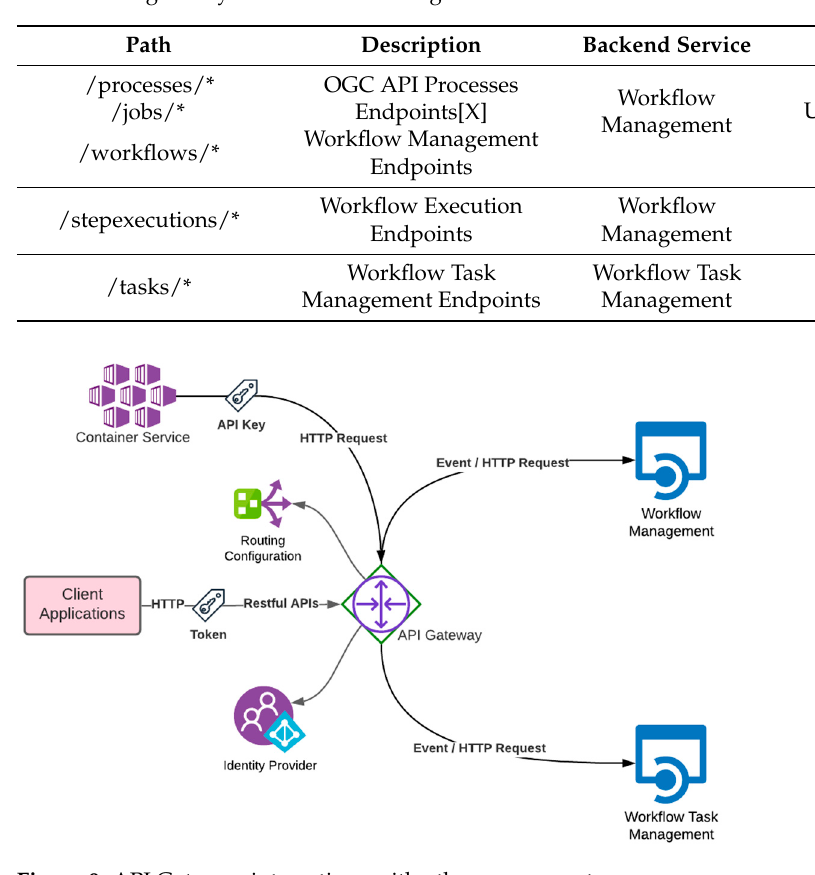
Figure 9. API Gateway interactions with other components.